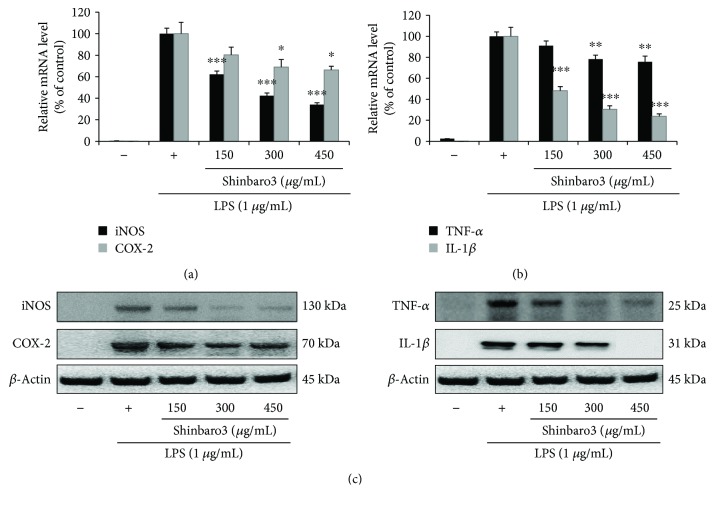
Effects of Shinbaro3 on the expression of inflammatory mediators in LPS-stimulated RAW 264.7 macrophage cells. RAW 264.7 cells were treated with LPS (1 μg/mL) and Shinbaro3 (150, 300, and 450 μg/mL) for 6 h to investigate mRNA expression (a, b) or 18 h to investigate protein expression (c). iNOS, COX-2, TNF-α and IL-1β mRNA, and protein expression levels were then analysed in real-time RT-PCR and Western blot assays, respectively. The results were normalized using β-actin as an internal control. Data are presented as the mean ± SD (n = 3). ∗p < 0.05, ∗∗p < 0.01, and ∗∗∗p < 0.001 versus LPS treatment alone.